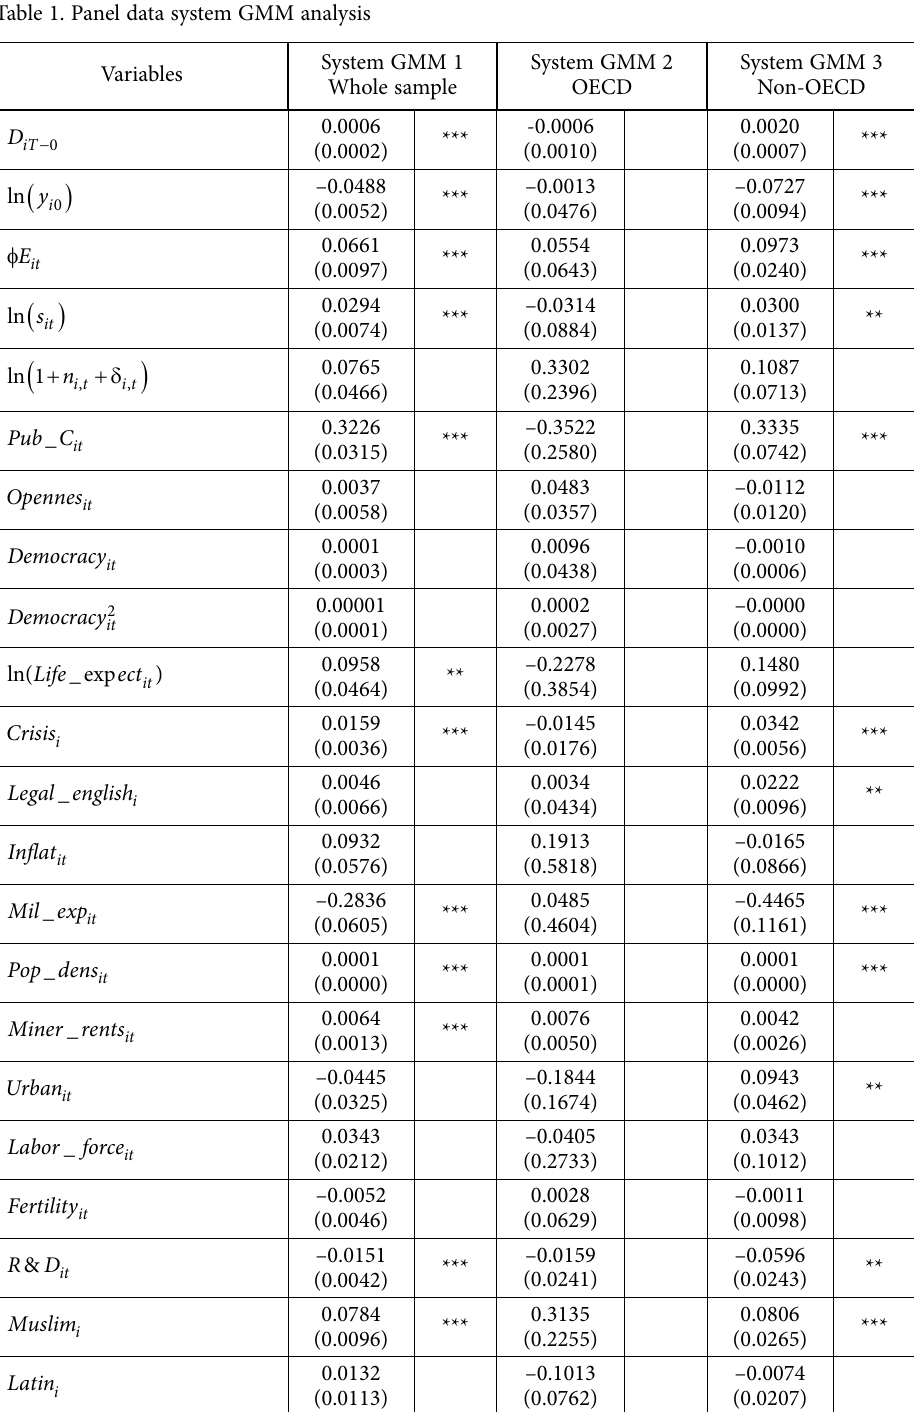
Table 1. Panel data system GMM